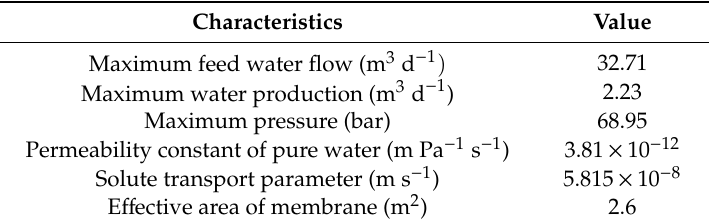
Table 2. Performance parameters of SW30-2540